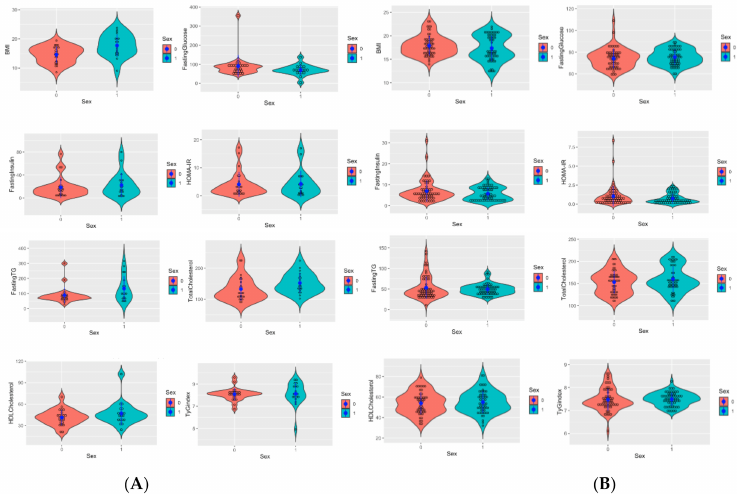
Figure 1. The panel shows the kernel density estimation by means of violin plots for the vari- ables related to the metabolism of the children-with-disabilities group ( A ) and the healthy con- trol group ( B ). In red, the distribution of observations in females, and in blue, the distribution of observations in